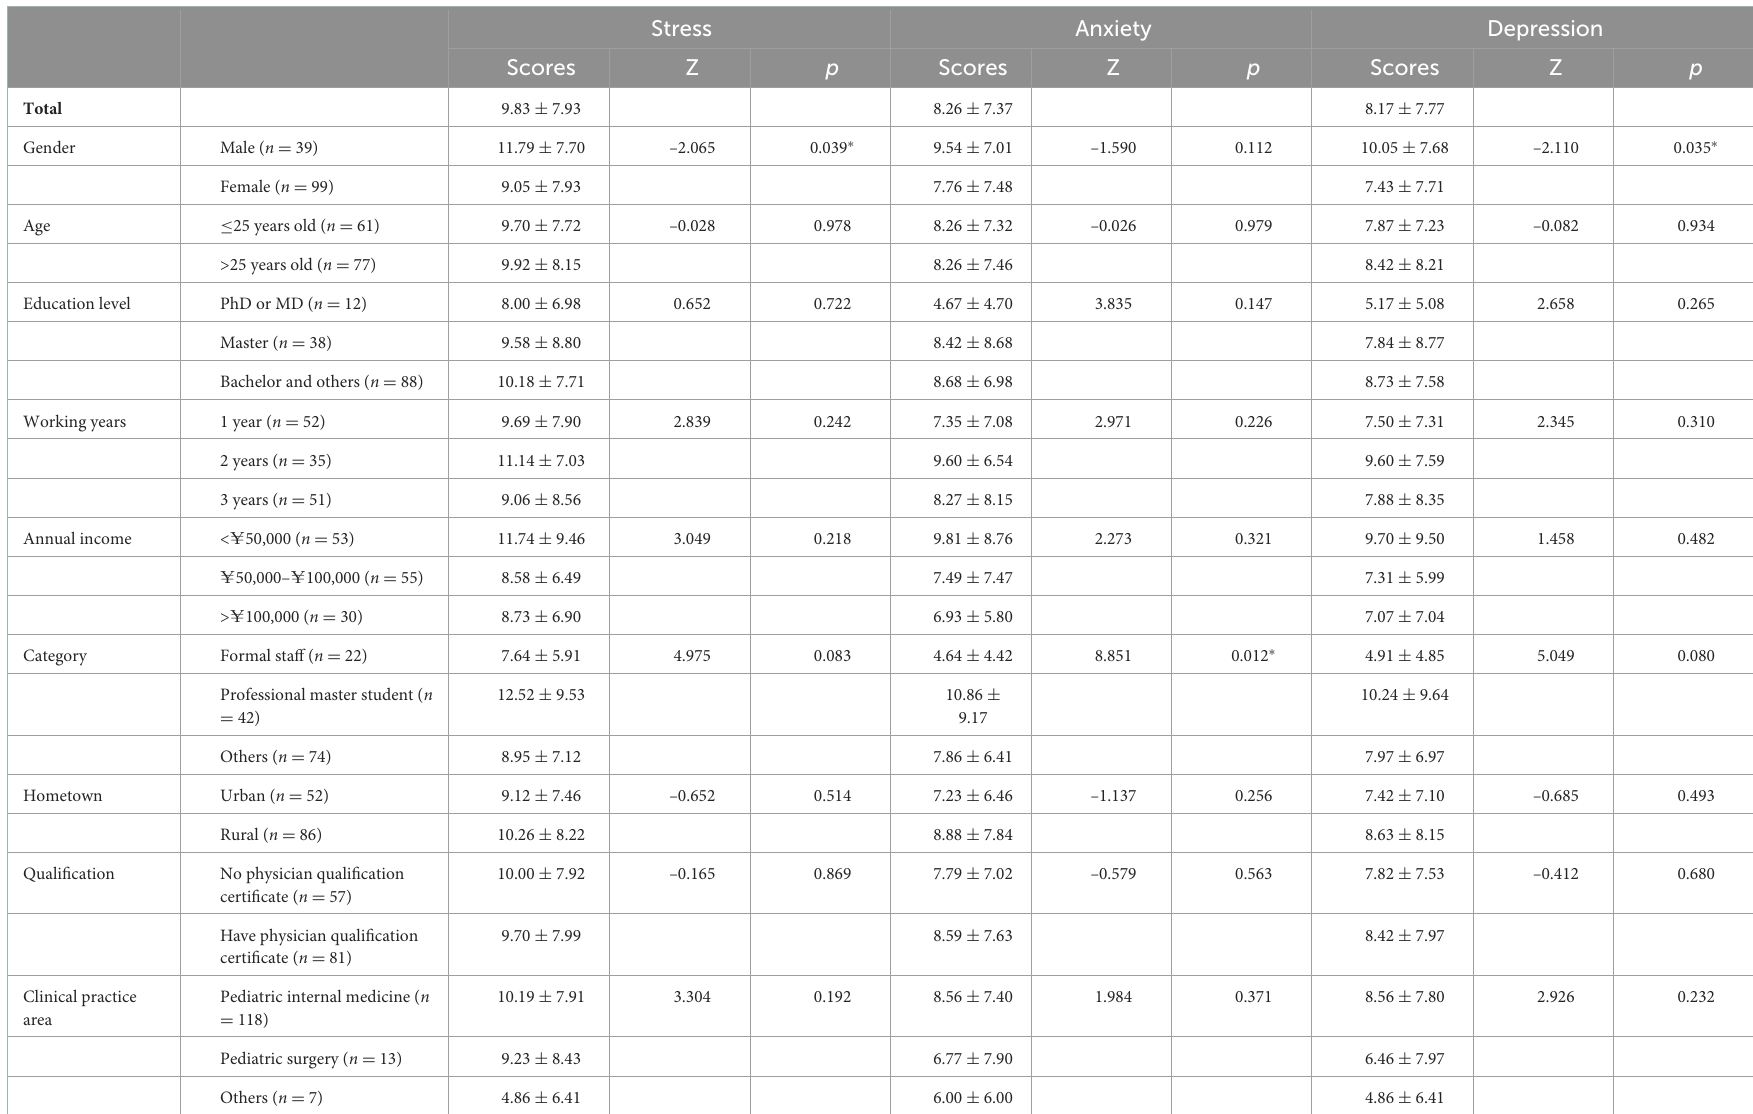
TABLE 2 Negative emotions of